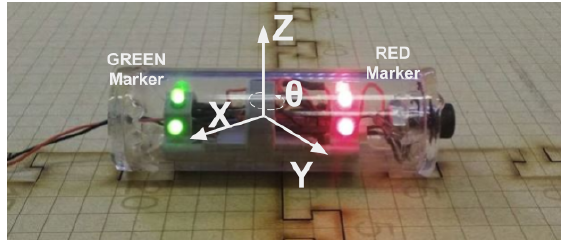
Figure 10. Miniature mock AVEXIS used for verification on